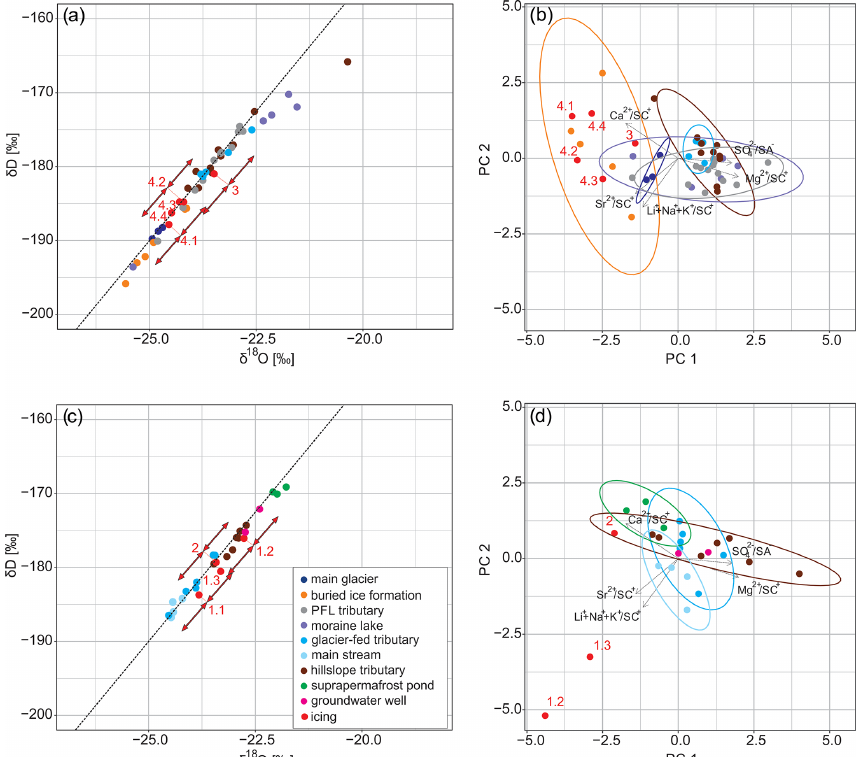
Figure 8. Isotopic and hydrochemical results for the Duke watershed. Panels (a) and (b) show icings and sources within the proglacial field; panels (c) and (d) show icings and sources within the alpine meadow. Panels (a) and (c) show results from stable water isotope analysis. The straight dashed line represents the local meteoric water line. Red arrows define the range within which samples from parent sources are considered to plot close to the icing sample. For samples from Icing 4, only arrows for the most depleted and the less depleted samples are included for readability. Panels (b) and (d) show results of the hydrochemical analysis, and the ellipses illustrate the 95% confidence